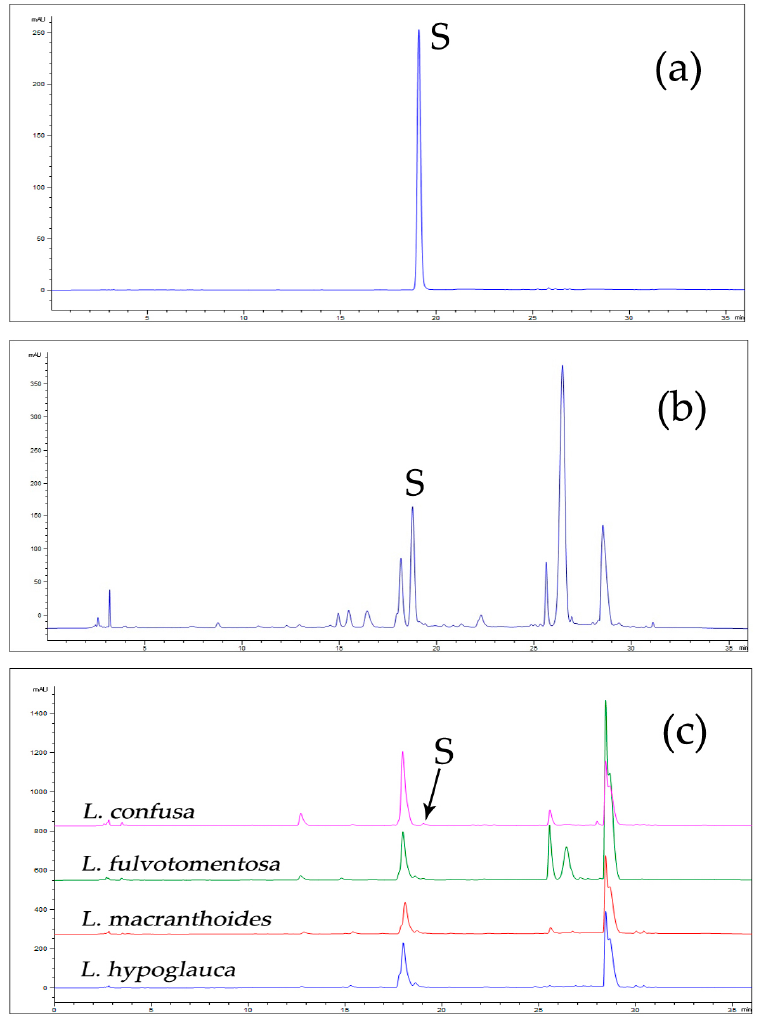
Figure 6. The HPLC chromatograms of standard (a) and samples. ( b ) LJF sample; ( c ) LF sample; S: secologanic acid. Column: An Agilent ZORBAX XDB C18 (4.6 × 250 mm, 5 μ m) column; column temperature, 30 °C; mobile phases: 0.1% phosphoric acid solution (A) and acetonitrile (B), using a gradient elution of 5 – 15% B at 0 – 20 min, 15 – 23% B at 20 – 25 min, 23 – 95% B at 25 – 26 min, and 95% B at 26 – 30 min; flow rate: 1.0 mL/min; detection wavelength: 240 nm; injection volume: 10 μ L. Table 1. Contents of secologanic acid in samples of LJF ( n = 3, ⎯ x ± SD).